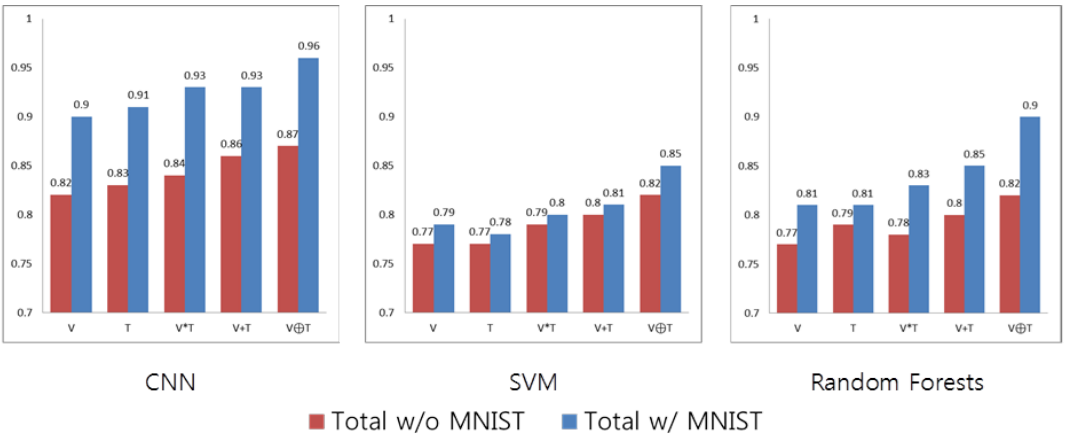
Figure 14. AUC comparison based on MNIST handwritten digits database